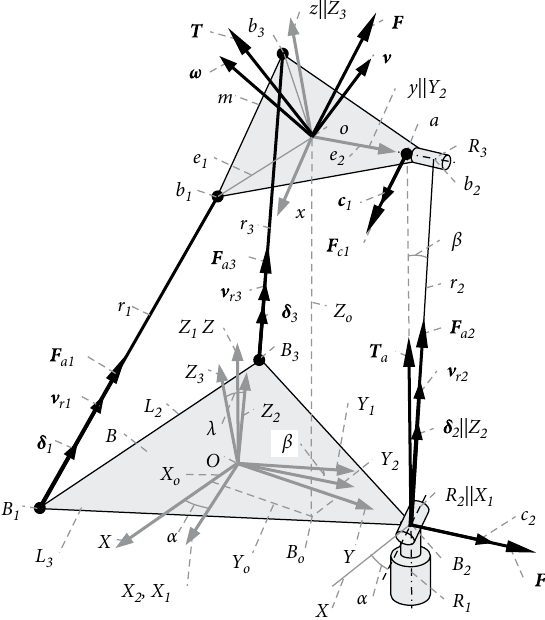
Figure 2: Kinematics and statics model of 2SPS+RRPR